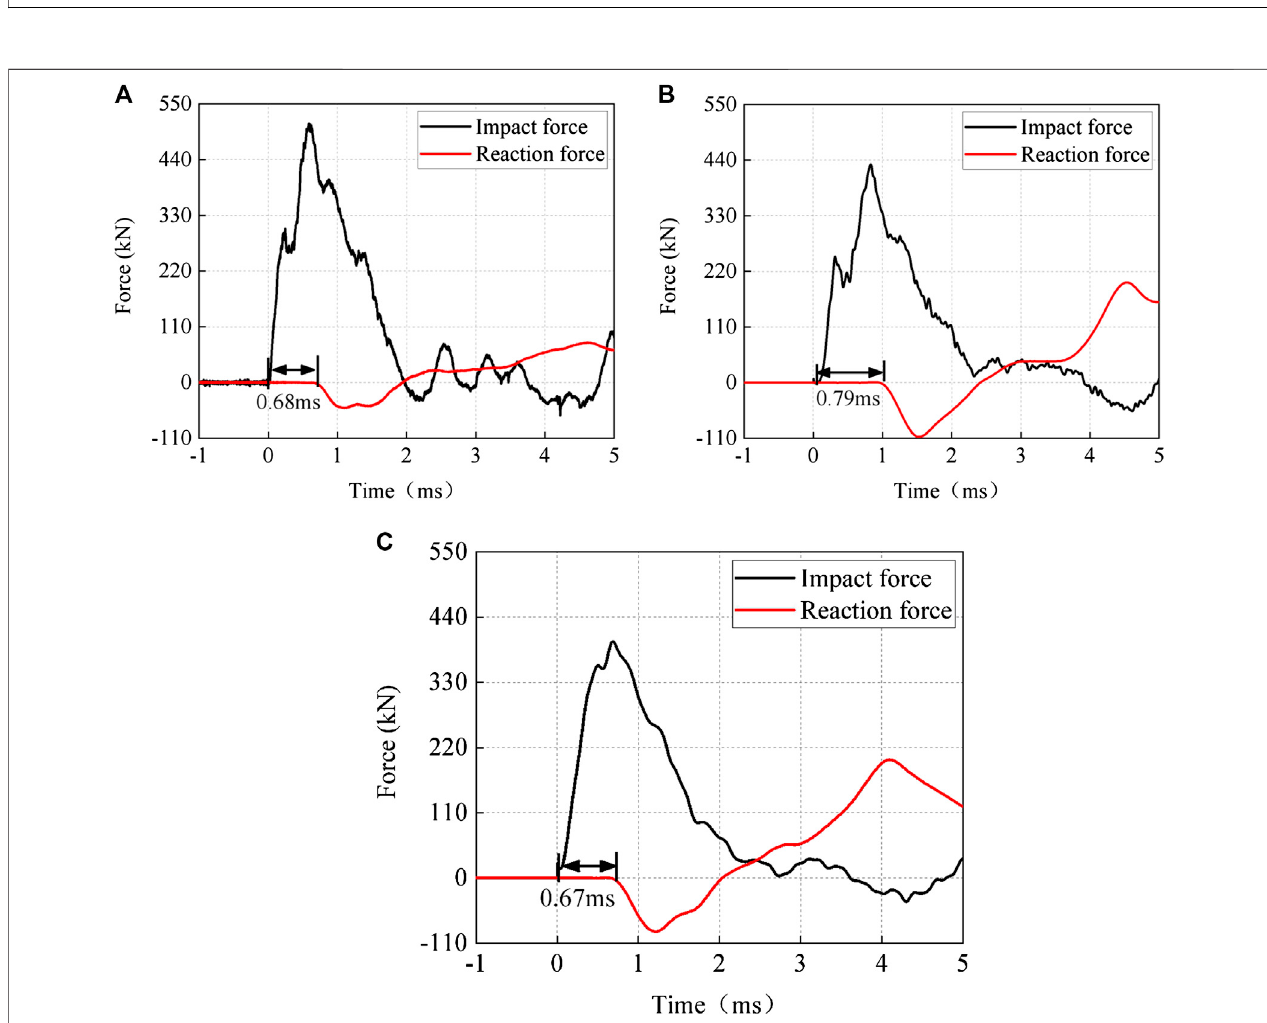
Frontiers in Materials |